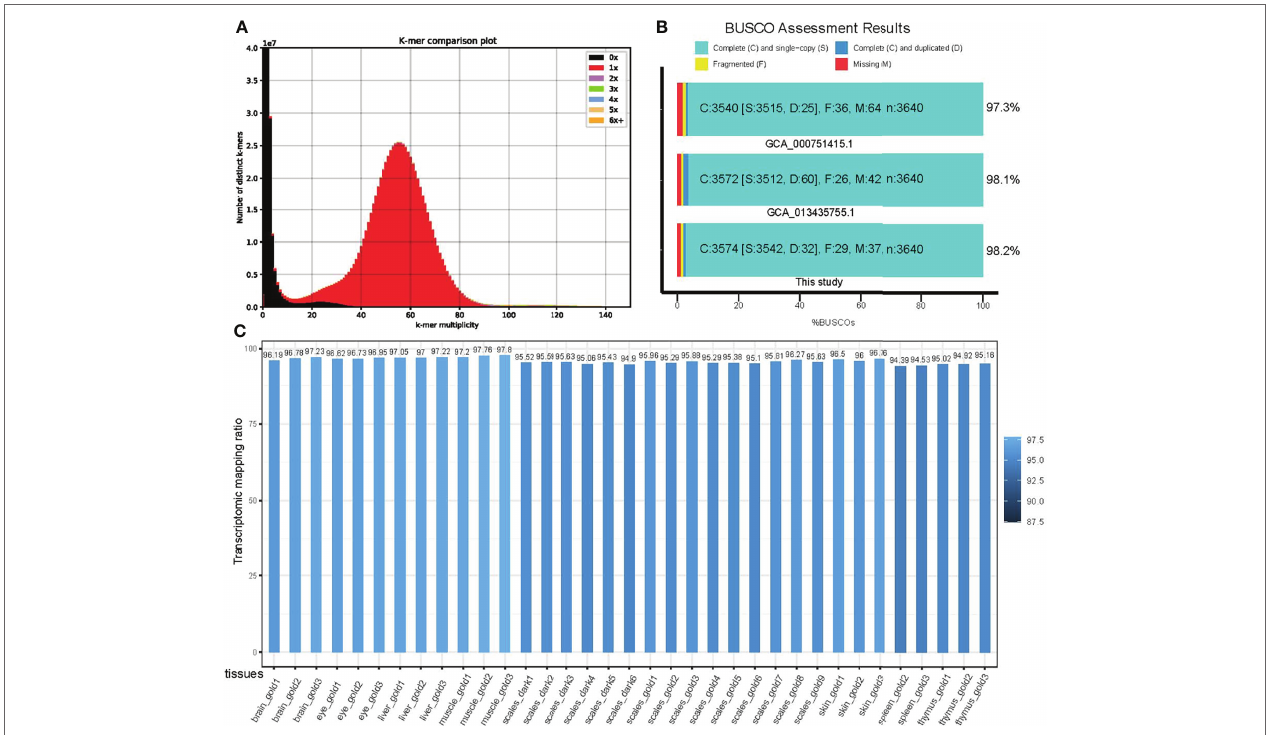
FIGURE 2 | Quality evaluation of the genome assembly of Midas cichlid. (A) A 31-mer spectrum comparison between our assembly and short-inserted libraries; (B) BUSCO completeness comparison among our assembly and two other previously reported versions; (C) Mapping ratios of 35 transcriptomes from different tissues and